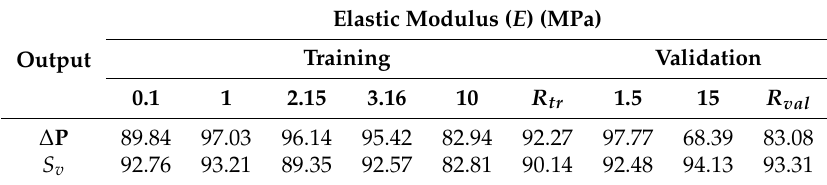
Figure 6. Validation results obtained using the coefficients maps to interpolate and extrapolate the new cases. In ( a ) we have results for the pressure difference cases and in ( b ) the reconstructed signals for opening area. Table 5. Average goodness of fit obtained for the training and validation